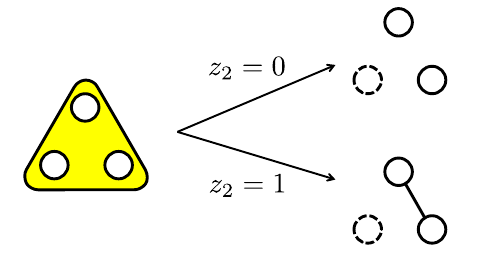
FIG. 3. A quantum state after the Z 2 -basis measurement on j G i . Solid-line and dashed-line circles represent jþi and a measured qubit, respectively. The yellow triangle and the black solid line f f CZ 1 CZ 1 represent and , ; 2 ; 3 ; 3